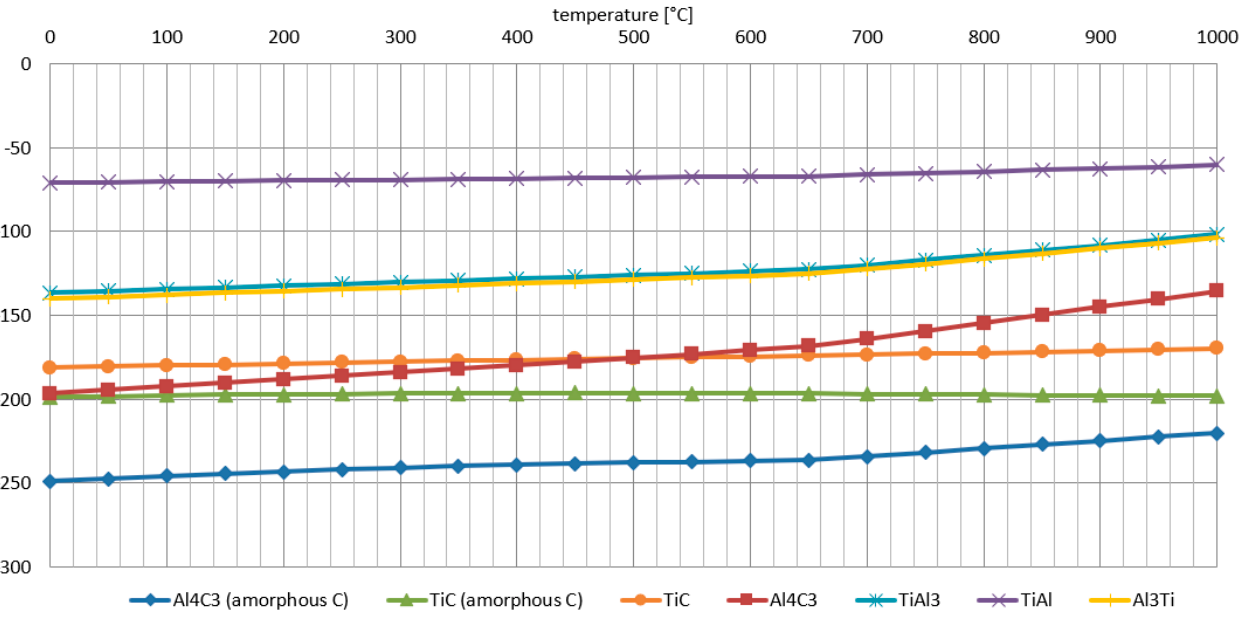
Figure 4. Free energy of formation in an Al-Ti-C (amorphous) system.